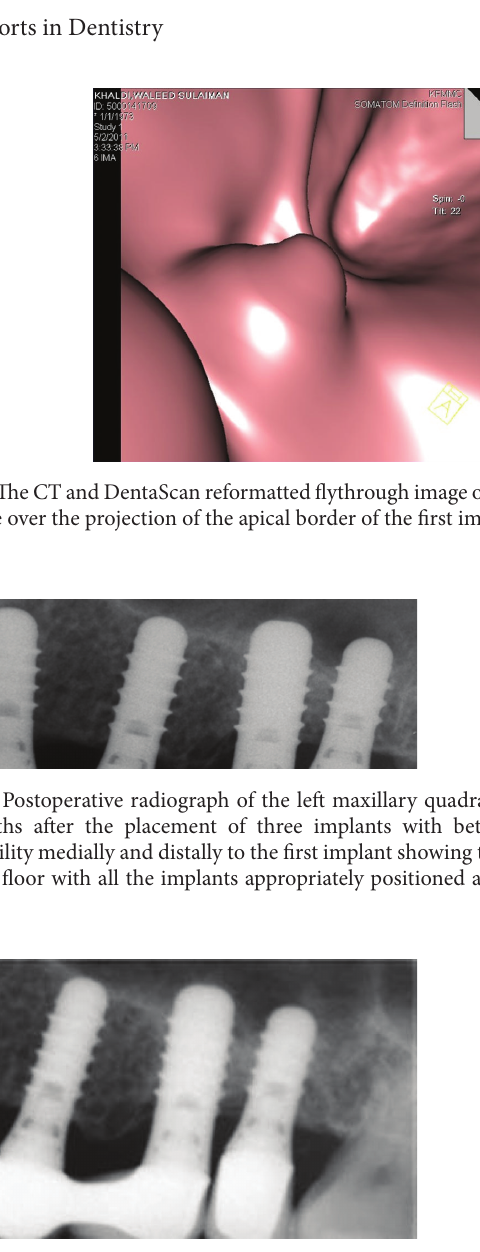
Figure 5: Periapical radiograph after 12 months of prosthetic loading showing a stable clinical situation in the area around the apex of the implants.